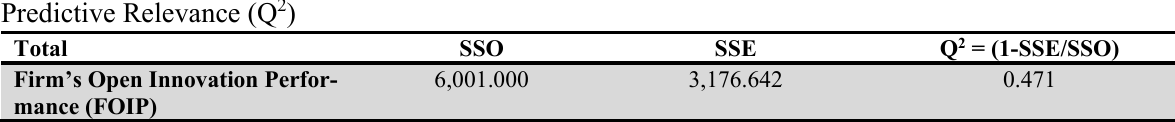
Predictive Relevance (Q 2